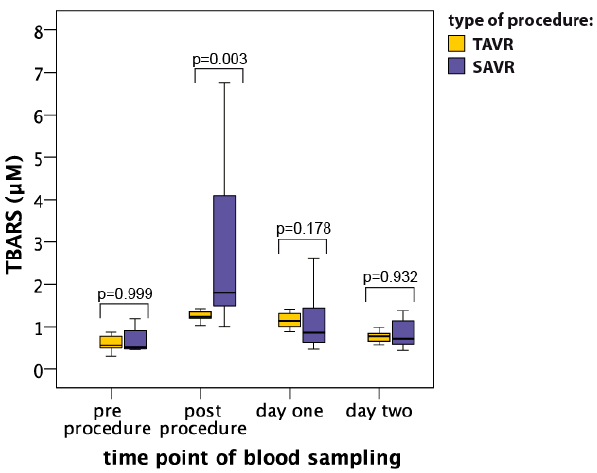
Figure 2. Serum thiobarbituric acid reactive substances (TBARS) level (median with interquartile range) in patients undergoing TAVR ( n = 12) and SAVR ( n = 12) procedures.